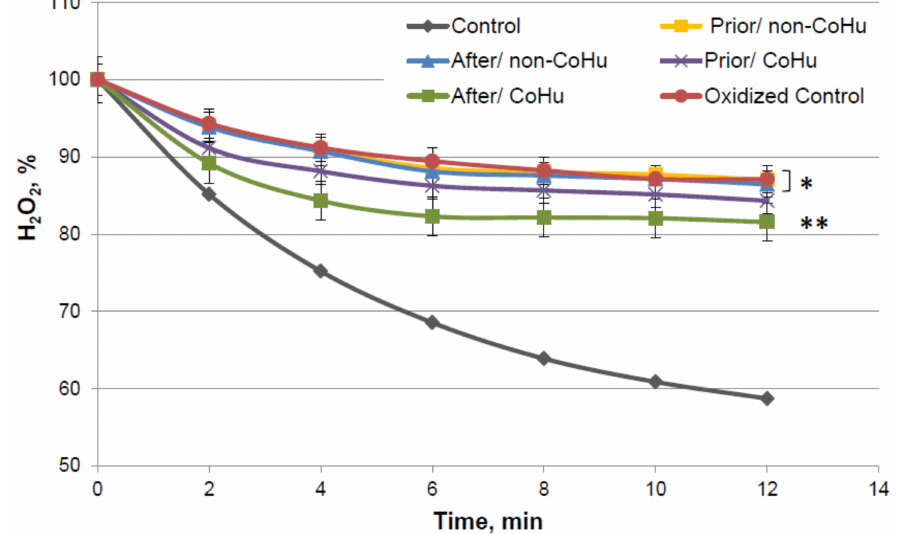
Figure 7. Residual quantity of H 2 O 2 (catalase substrate) in the catalase-assisted degradation reaction. Data reflect the activity of the enzyme. * and **—Lines with different superscripts differ significantly ( p <